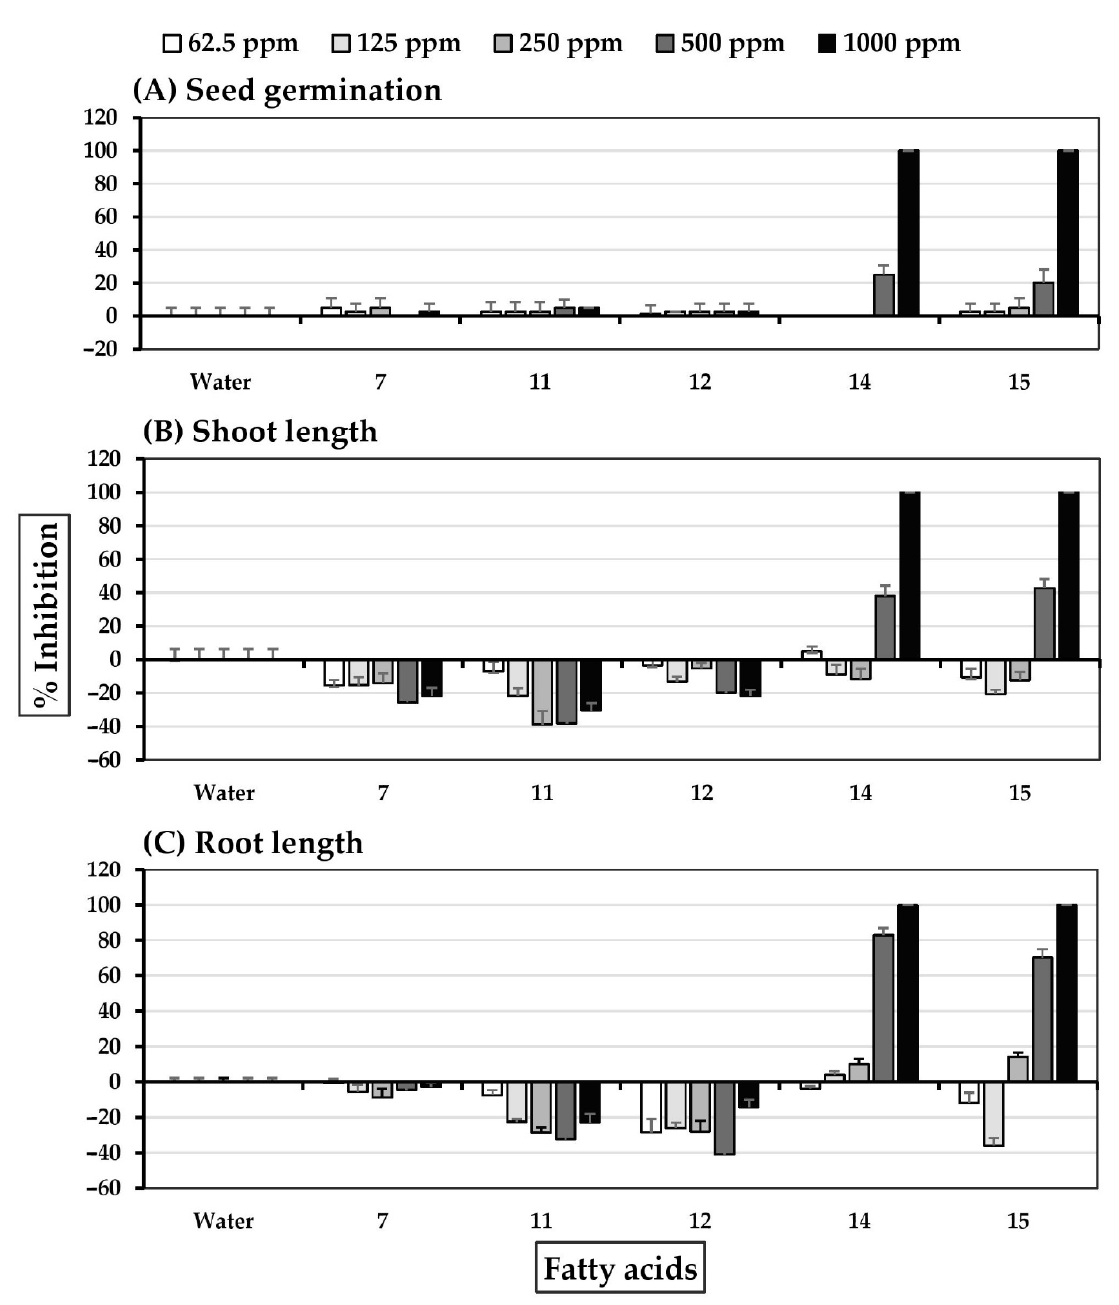
Figure 7. Inhibitory effects of fatty acids of S. platensis on ( A ) seed germination, ( B ) shoot length, and ( C ) root length of Chinses amaranth. Distilled water was used as a